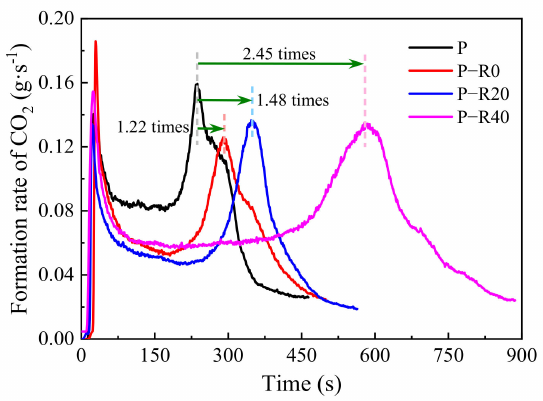
Figure 11. Carbon dioxide production of control and modified wood specimens.